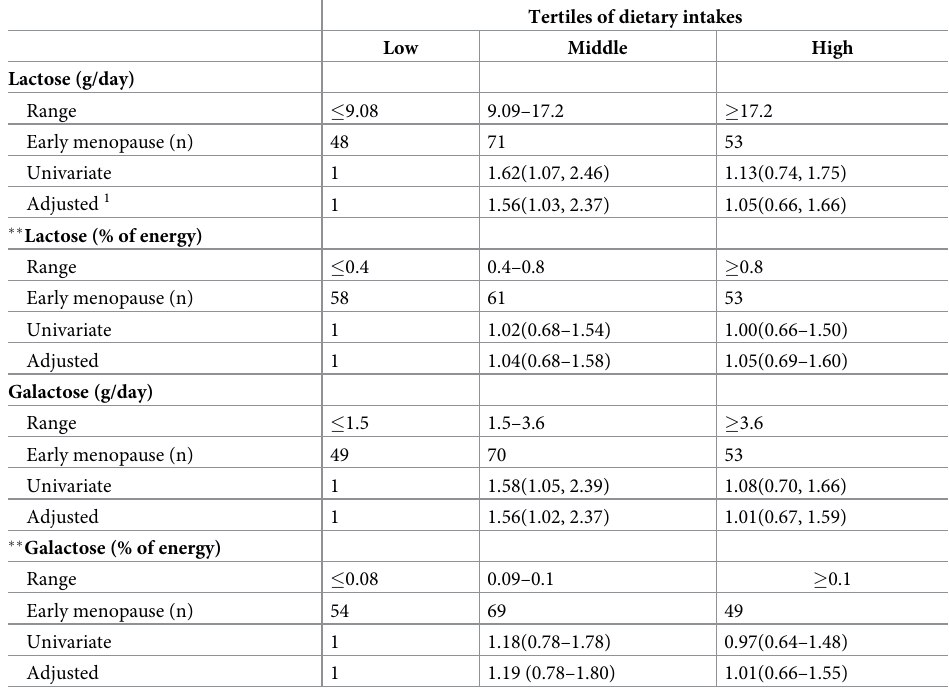
Table 2. Odds ratios (ORs) for early menopause (age � 45 years) based on daily intakes of lactose and galactose � .